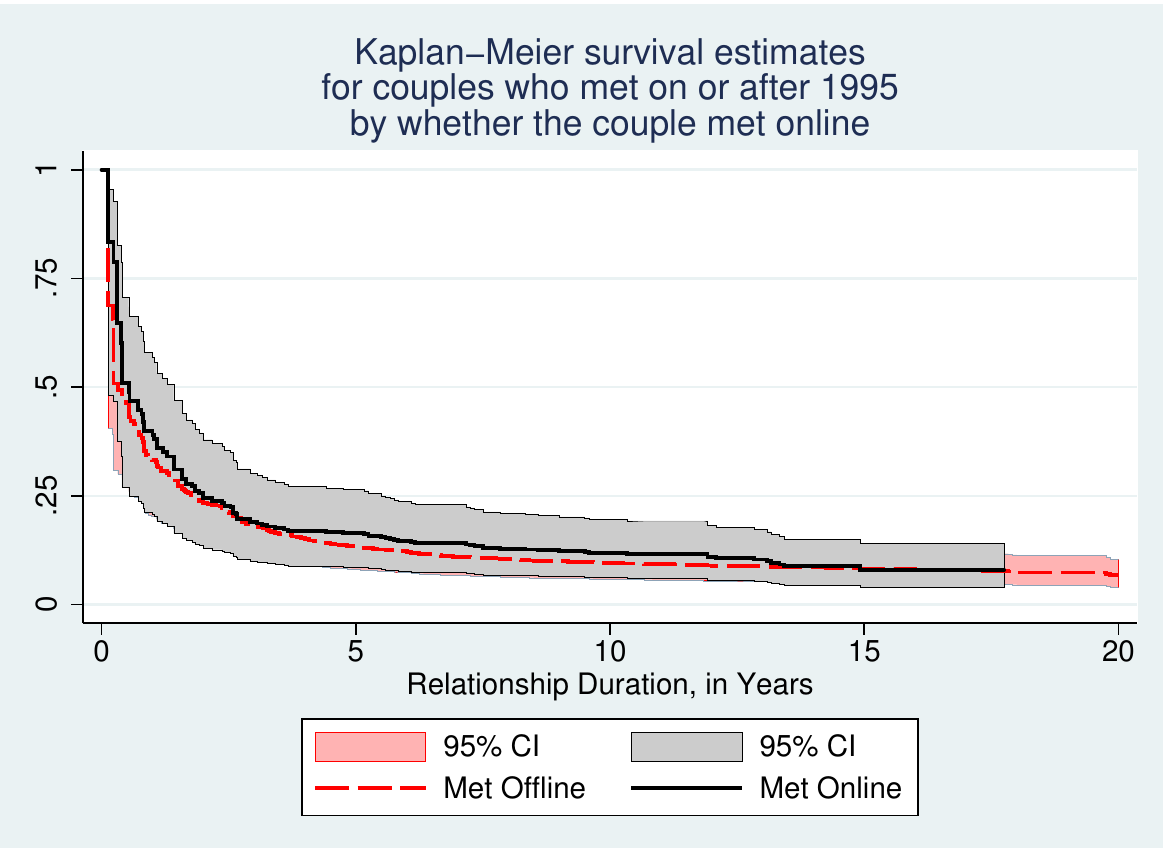
Figure 1: Meeting online not associated with lower couple longevity. Source: HCMST prospective event history data, covering breakups between 2009 and 2015. Data are unweighted. Cumulative survival in this case means couple survival as an intact couple (i.e., without breakup). The number of breakup events was 94 for couples who met online and 300 for couples who met